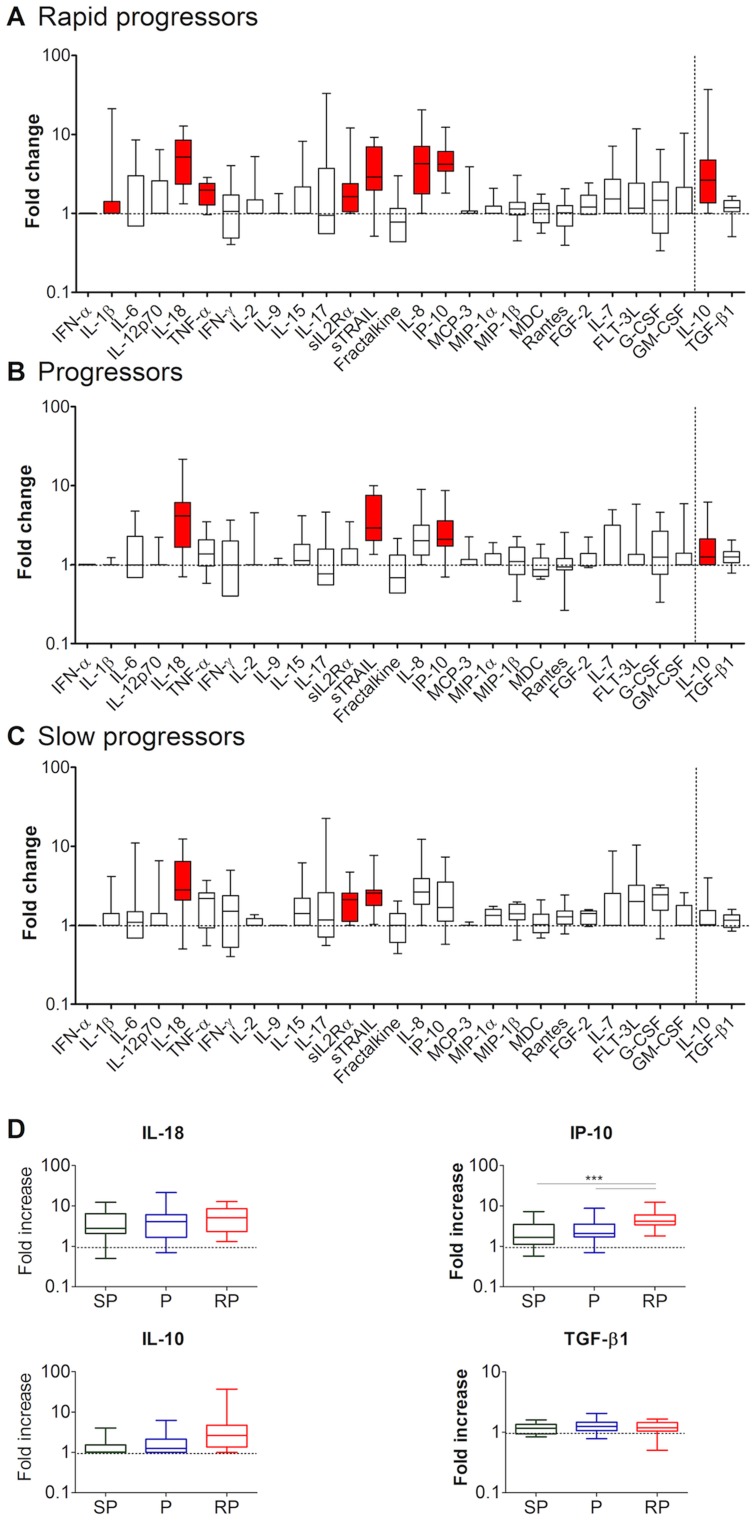
Plasma protein levels at M0 according to disease progression profiles.The cytokine profiles at M0 are shown for each group of patients: 16 rapid progressors (A), 19 progressors (B), and 11 slow progressors (C). Color code and statistical analyses are as described in Figure 2 (corrected threshold, p<0.005). The dotted horizontal line corresponds to the value in healthy donors. (D) Comparison of protein concentrations between the 3 groups of patients (SP, P and RP). Four representative cytokines are shown. The cytokines increasing significantly over groups were IP-10 and IL-10 (Cuzick’s test, p<0.007). When comparing the groups two by two, out of 28 proteins tested, the levels were different only for IP-10 (M&W test,***: p<0.005).